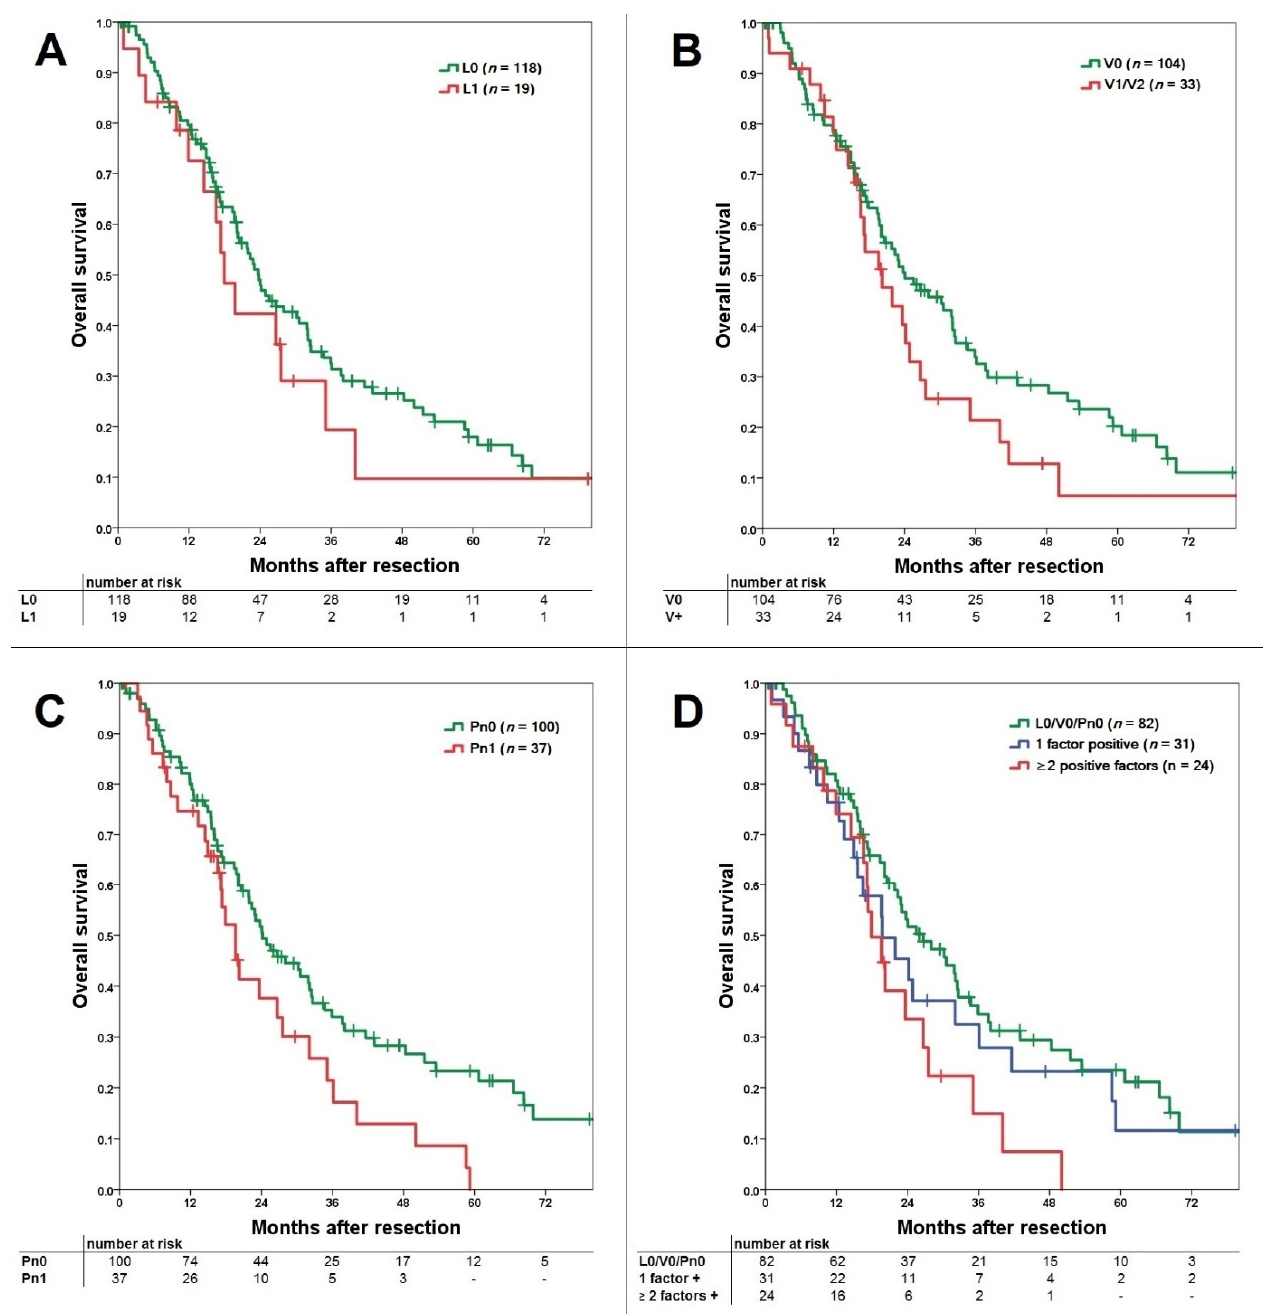
Figure 1. ( A ) Comparison of overall survival for lymphangioinvasion with comparable survival for the L0 and L1 group ( p = 0.369). ( B ) Comparison of overall survival for vascular invasion with comparable survival for the V0 and V+ (V1 + V2) group ( p = 0.149). ( C ) Comparison of overall survival for perineural invasion with significantly better survival for the Pn0 over the Pn1 group ( p = 0.027). ( D ) Comparison of overall survival for L0/V0/Pn0 versus 1 positive factor and ≥ 2 positive factors groups ( p = 0.091). In subgroup comparison the L0/V0/Pn0 was significantly better compared to the ≥ 2 positive factors group ( p = 0.025), while 1 positive factor vs. ≥ 2 positive factors was comparable ( p =